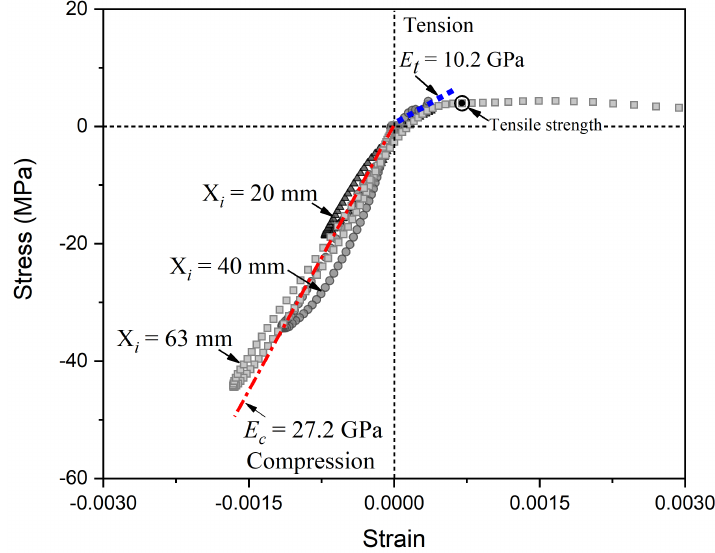
Figure 11. The non-linear behaviors of stress–strain curves for the compression and tension stages including the non-linear increasing elasticity, the different elastic modulus of tension and compression, and non-linear hysteresis loop, for the spalling test under the loading rate of 33